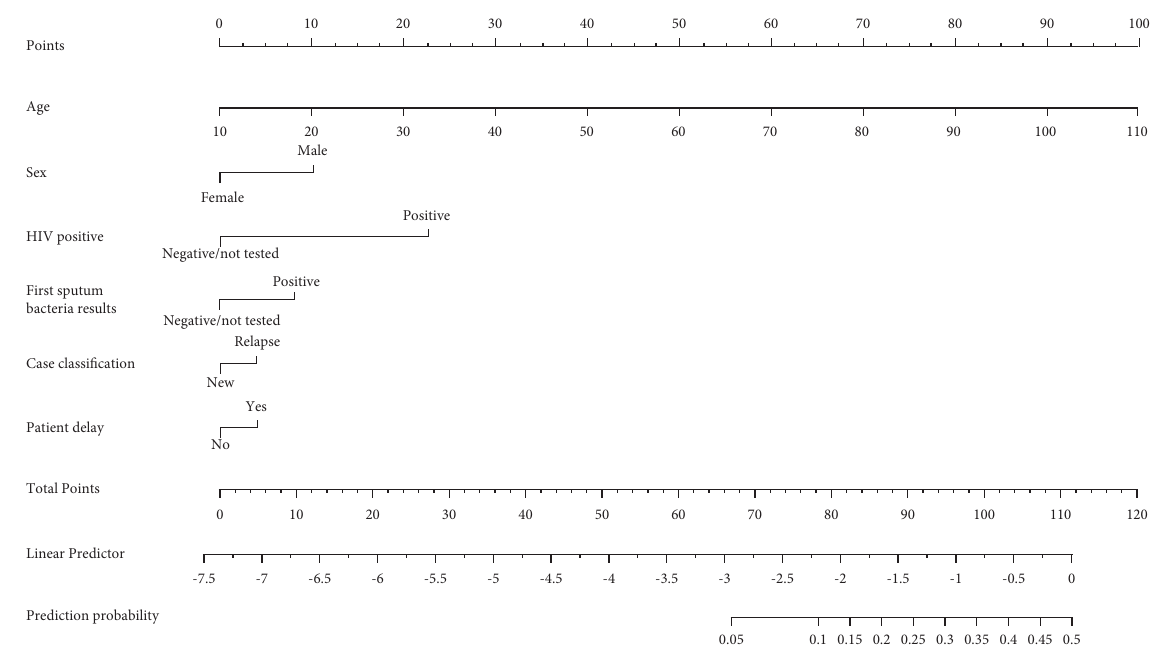
Figure 2: A nomogram predicting the risk of mortality among pulmonary tuberculosis patients under the DOTS strategy. (Te value of each variable was given a score on the point scale axis. A total score could be easily calculated by adding every single score, and by projecting the total score to the lower total point scale, we were able to estimate the probability of pulmonary tuberculosis.). Table 4: Nomogram scores of the risk of mortality among pul- monary tuberculosis patients under the DOTS